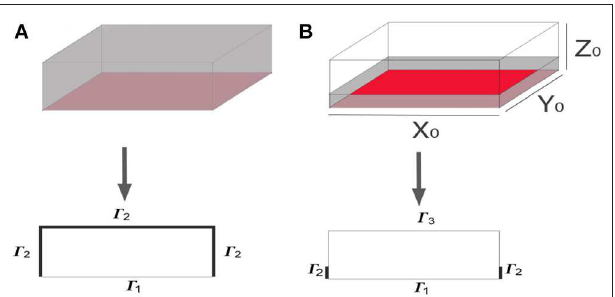
FIGURE 1 | Dimensional reduction of 3D physical situations. (A) Physical situation with Ŵ 1 in contact with free water and an insulated boundary Ŵ 2 . (B) System with three boundary conditions: a Dirichlet type on Ŵ 1 describing the boundary in contact with free water, a no nil Neumann type on Ŵ 2 describing the outward flux of water, and a nil Neumann type on Ŵ 3 used to describe the insulated boundary.